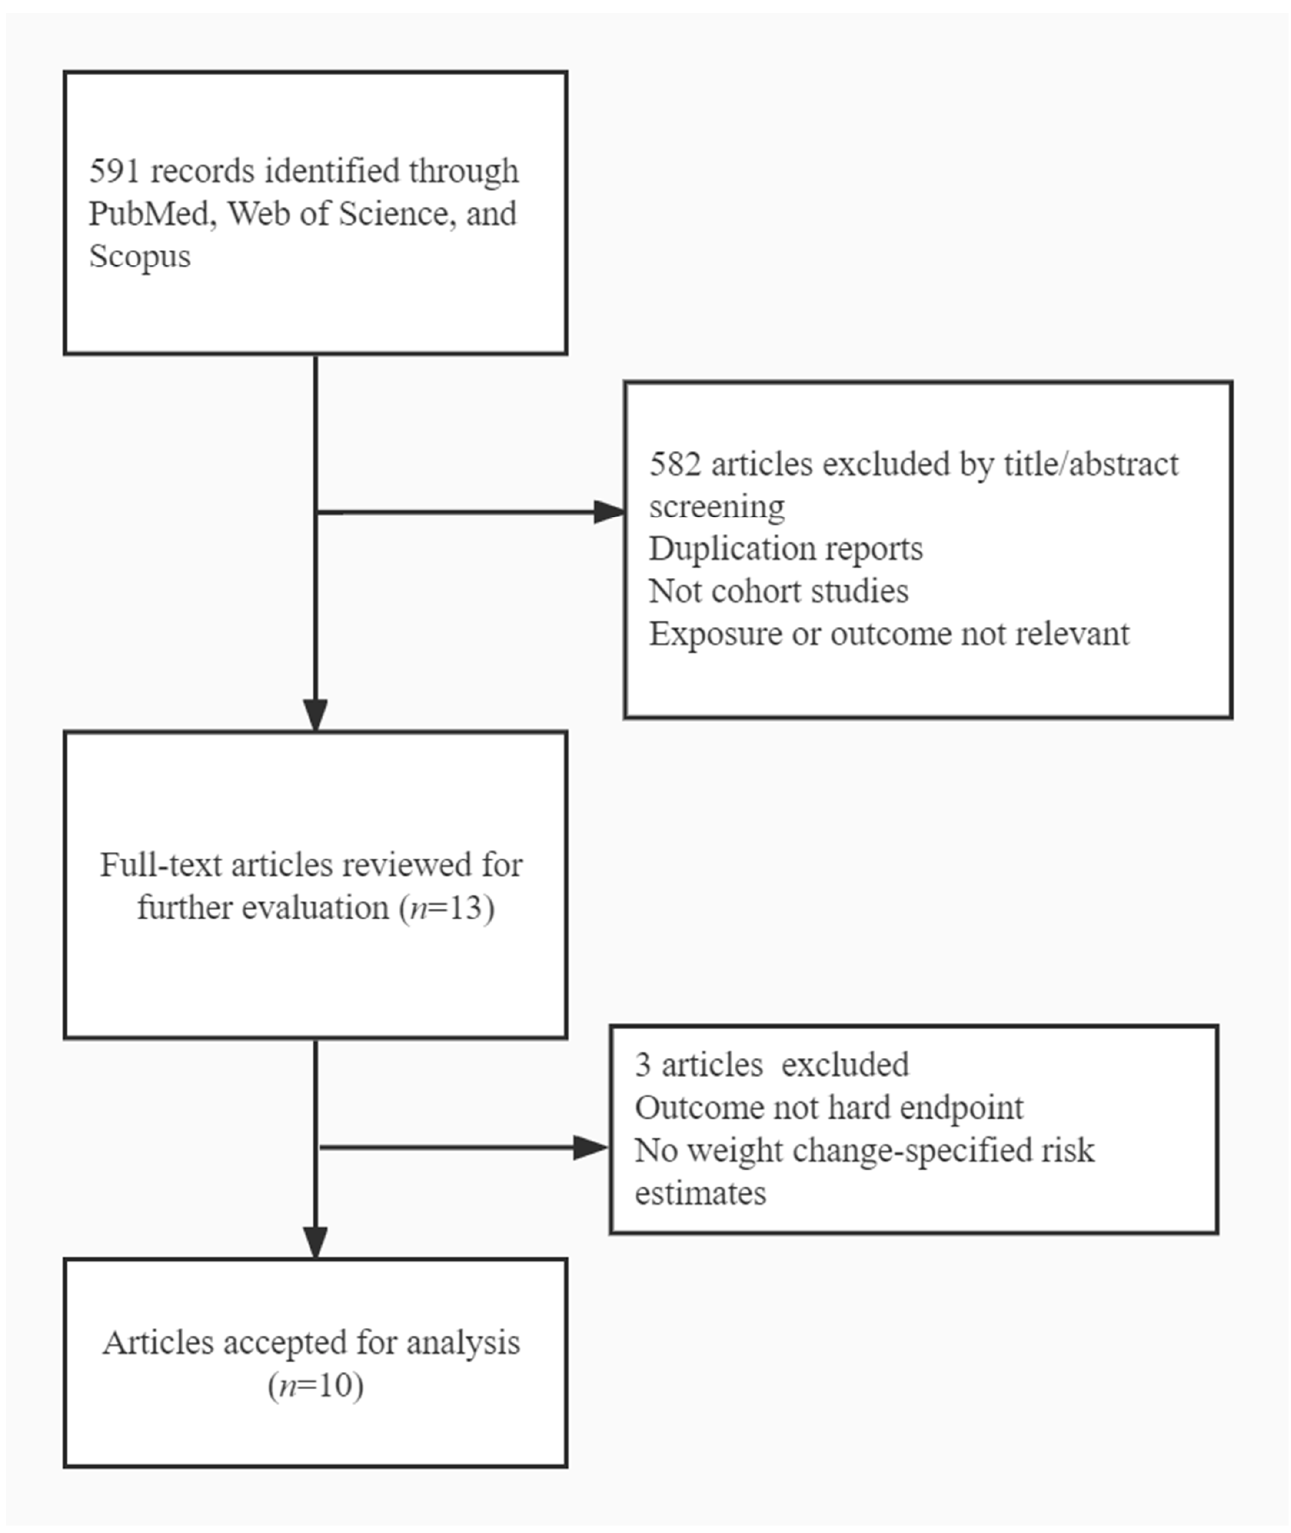
Figure 1. Flow chart of study selection.